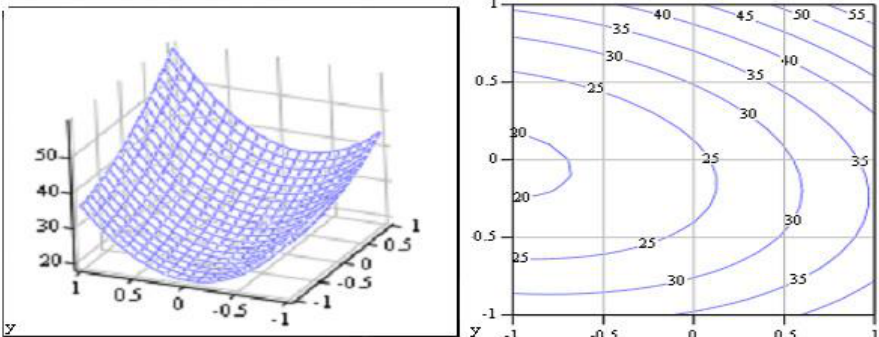
Figure 4. The graph and contour curves of the dependence of the criteria Y on the factors х 3 , х 2 for cherries, when х 1 = 0.